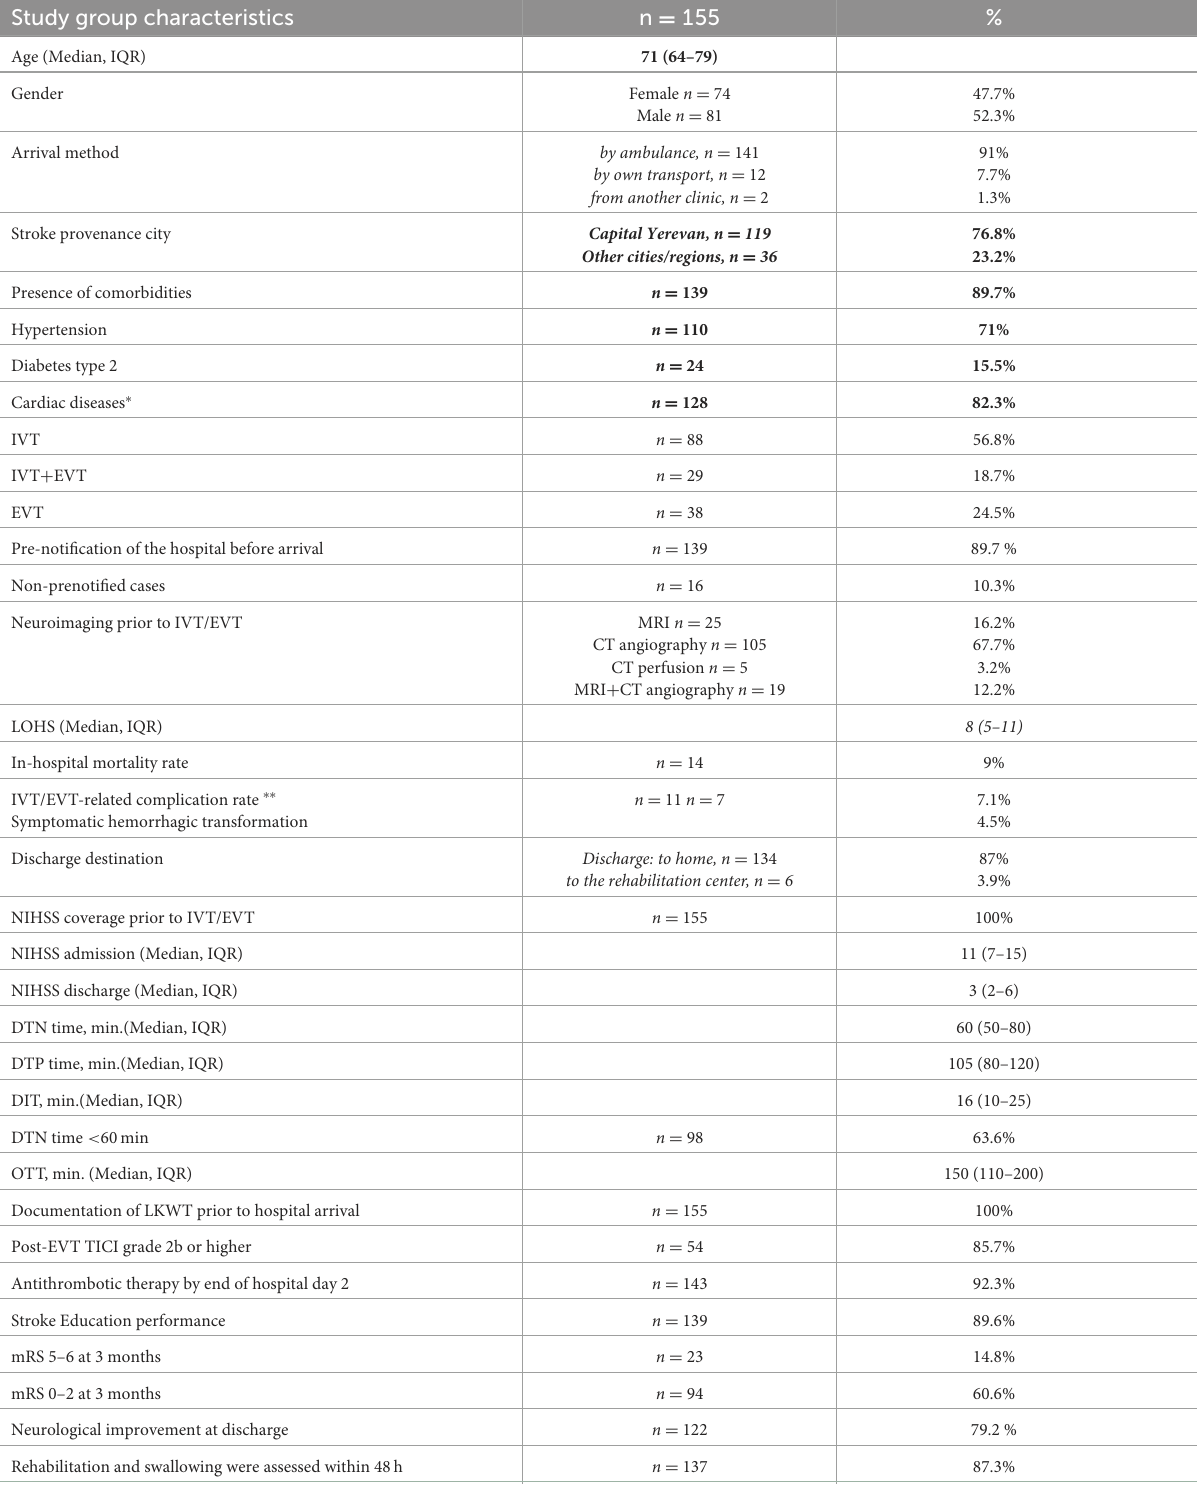
TABLE 1 Baseline characteristics of patients and stroke service. Study group